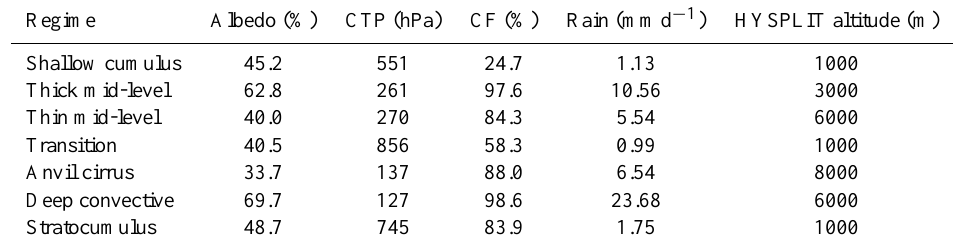
Table 1. Cloud regimes used in this study, from Gryspeerdt and Stier (2012). The mean GPCP rain rate (Huffman et al., 2009) and the initial height used for the HYSPLIT trajectory analysis are also included.